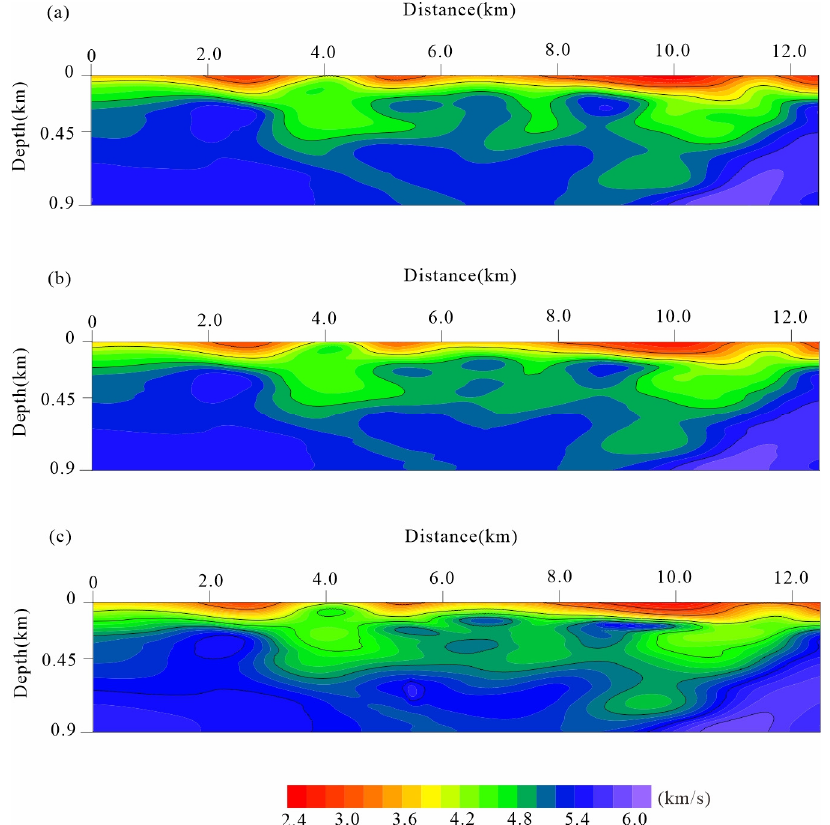
Figure 9. Multiscale velocity models obtained by early arrival waveform inversion with different frequency bands. ( a – c ) represent the inversion results at three frequency bands [1.4–4.9], [4.3–14.7], and [14.4–48.9].